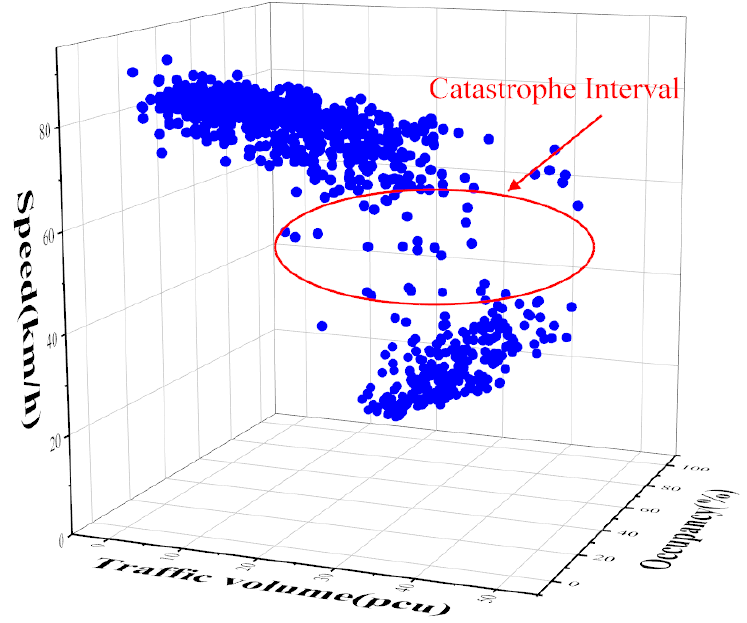
Figure 1. Data of traffic flow according to simulation.